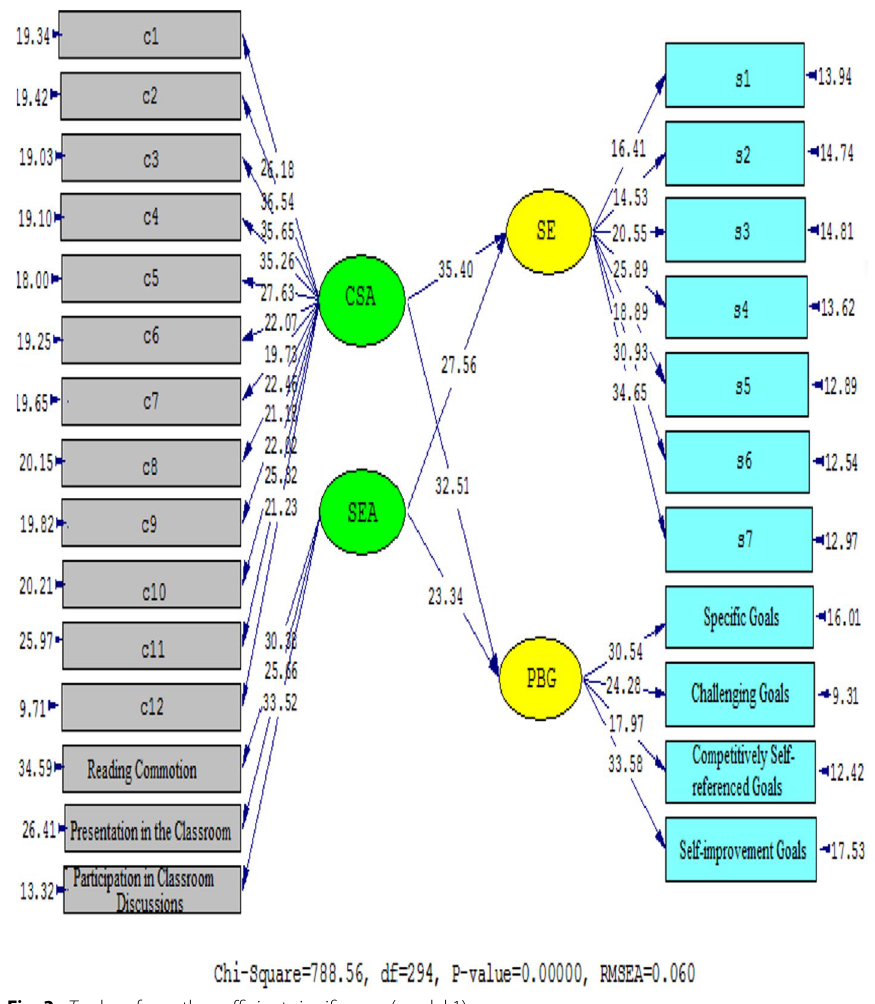
Fig. 3 T values for path coefficient significance (model